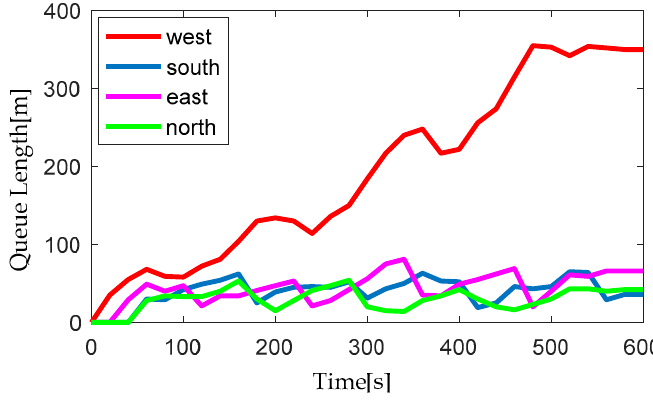
Figure 7. Simulation results.